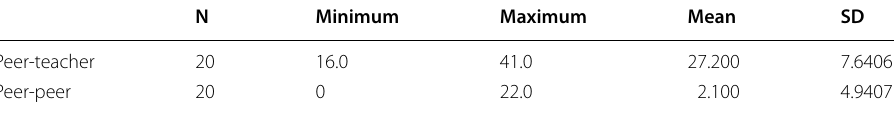
Table 8 Descriptive statistics of peer interaction and student–teacher